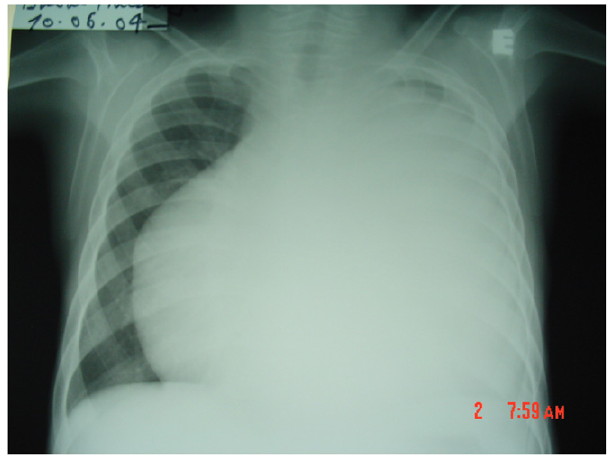
Figure 2. Chest radiography of a child with advanced right EMF showing cardiomegaly with right atrial dilatation and abundant left pleural effusion. Due to the presence of advanced heart failure, ascitis and cachexia cardiopulmonary exercise testing is of limited clinical application in patients with EMF. Therefore, the left atrial dimension has been proposed to estimate the functional capacity